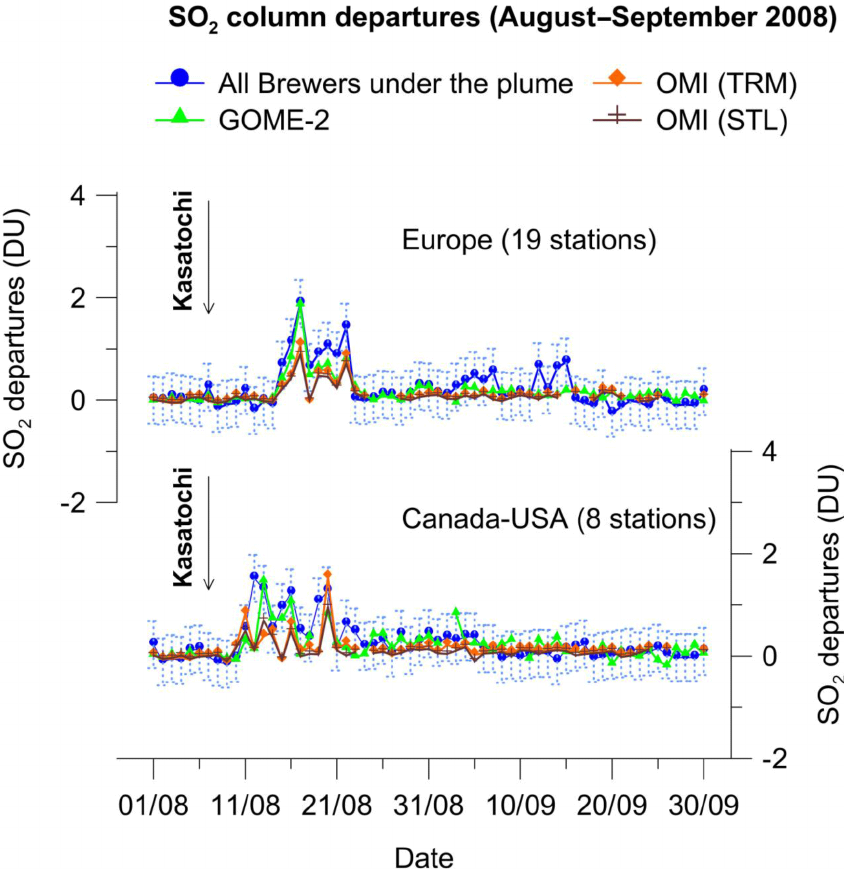
Figure 14. Mean SO 2 column departures from the unperturbed 10-day pre-volcanic baseline measured by Brewers, OMI (TRM, STL) and GOME-2 during August–September 2008 over Europe and Canada and the USA following the 2008 Kasatochi volcanic eruption. The error bars for the Brewer observations show the standard deviation of all daily values during the unperturbed 10-day period prior to the volcanic eruption. Stations in Europe include Sodankylä, Vindeln, Jokioinen, Norrköping, Copenhagen, Manchester, De Bilt, Belsk, Reading, Uccle, Hradec Králové, Hohenpeißenberg, Davos, Arosa, Aosta, Kislovodsk, Rome, Thessaloniki and Athens. Stations in Canada and the USA include Churchill, Edmonton, Goose Bay, Regina, Saturna Island, Toronto, Boulder and Mauna Loa. Each daily average from either OMI or GOME-2 was calculated if and only if more than half of the individual overpasses had data on a given day. The arrow marks the date of the eruption (7 August